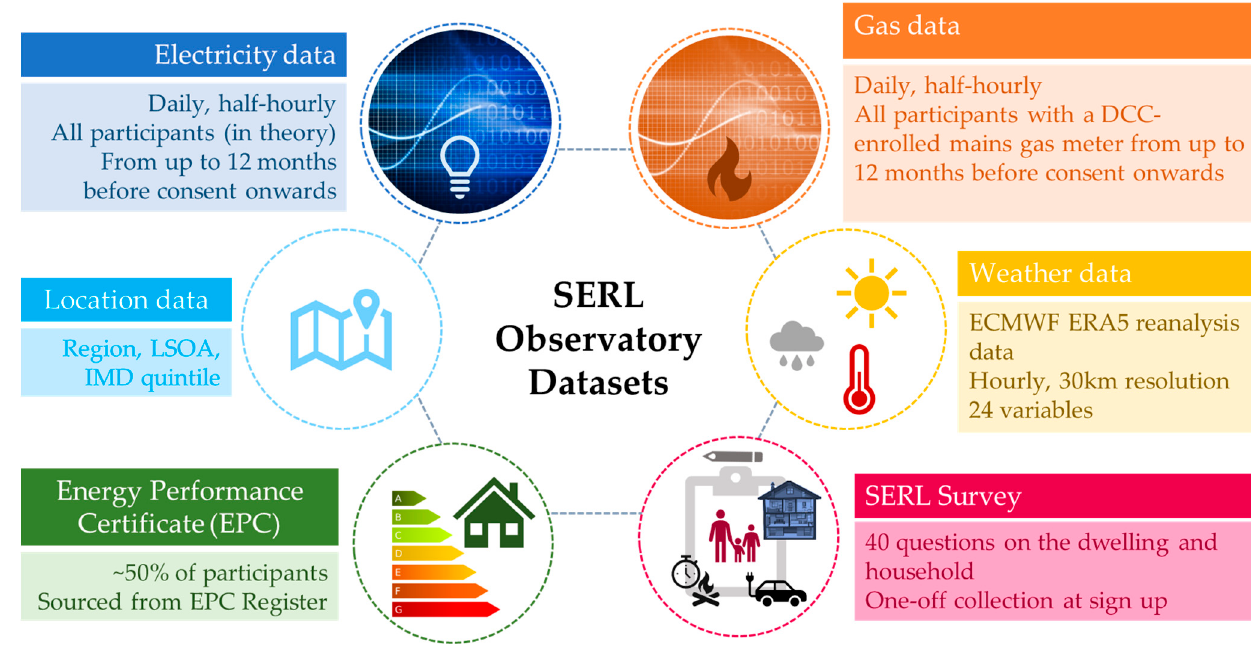
Figure 1. Overview of the SERL Observatory datasets.